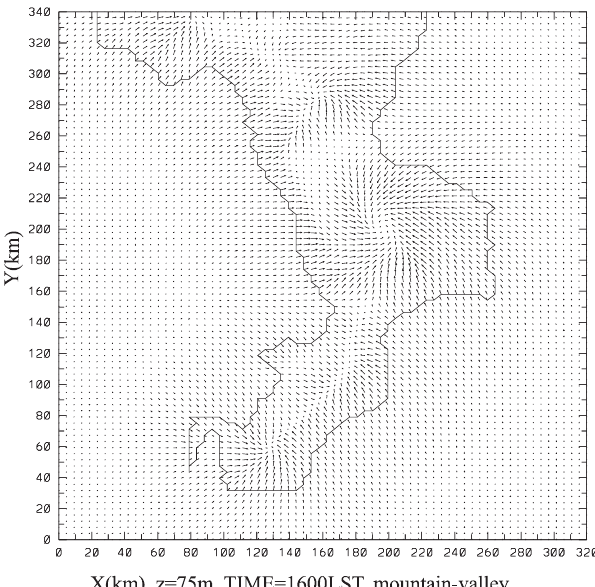
Fig. 9. As in Fig. 8 but for the mountain-valley flow